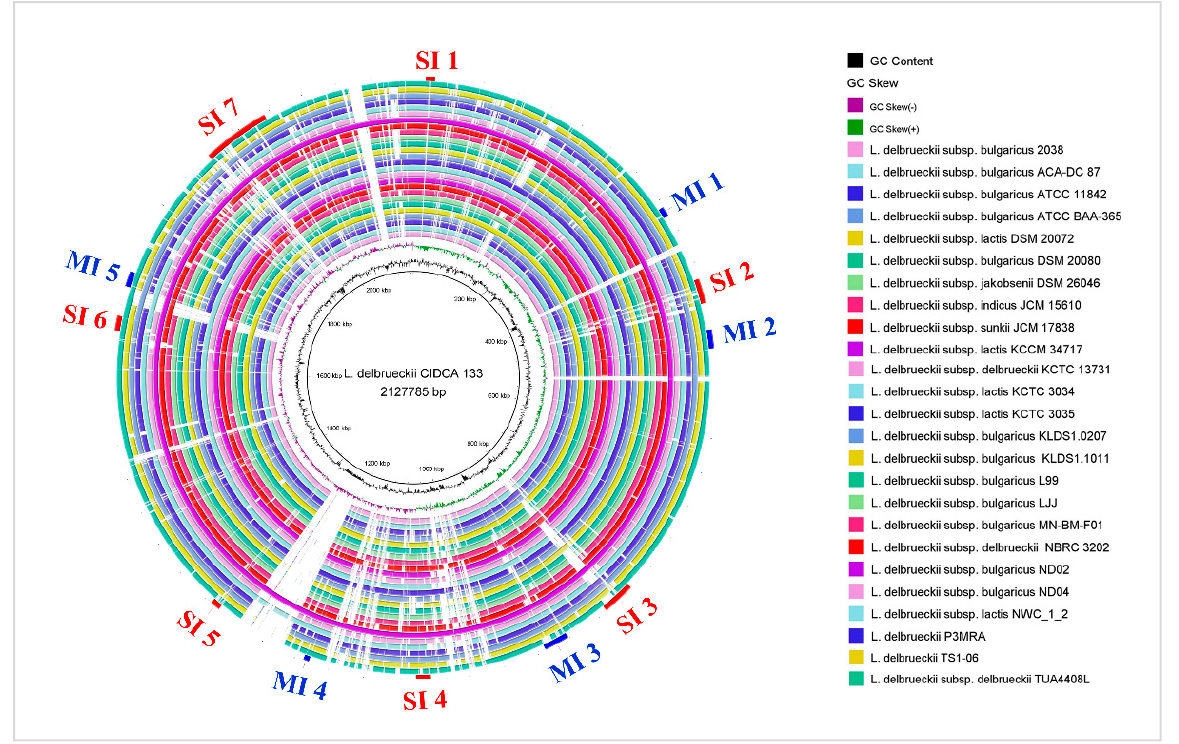
Figure 5. Circular schematic representation of Metabolic (MI) and Symbiotic (SI) islands predicted with GIPSy software in CIDCA 133 genome and its comparison with others L. delbrueckii complete genomes. Each ring of the circle corresponds to a specific L. delbrueckii whole genome, represented by different colors in the legend